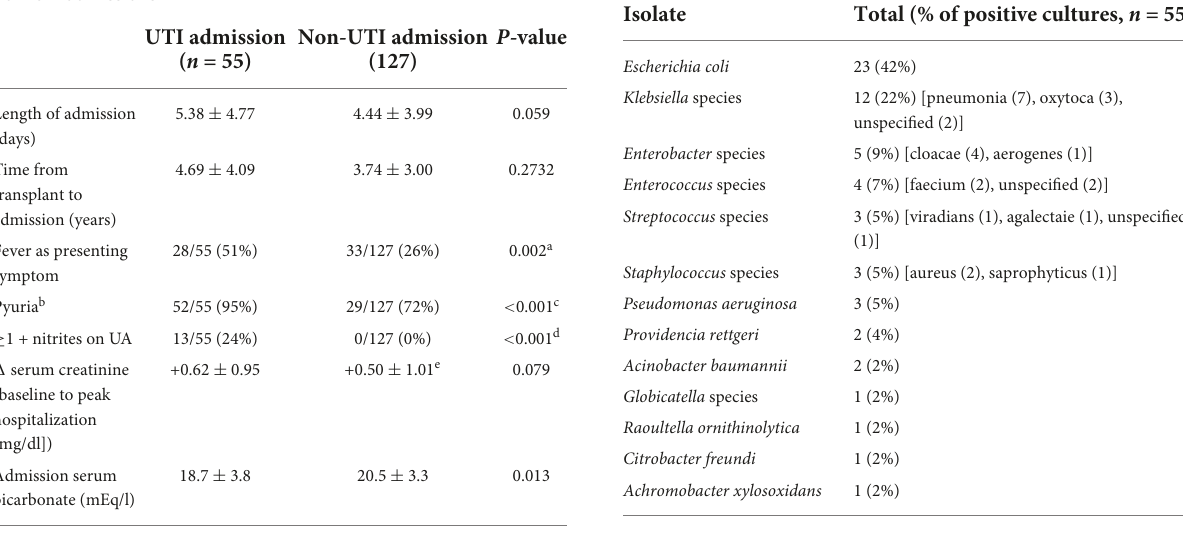
TABLE 6 Comparison of urinary tract infection (UTI) admissions vs. non-UTI admissions.